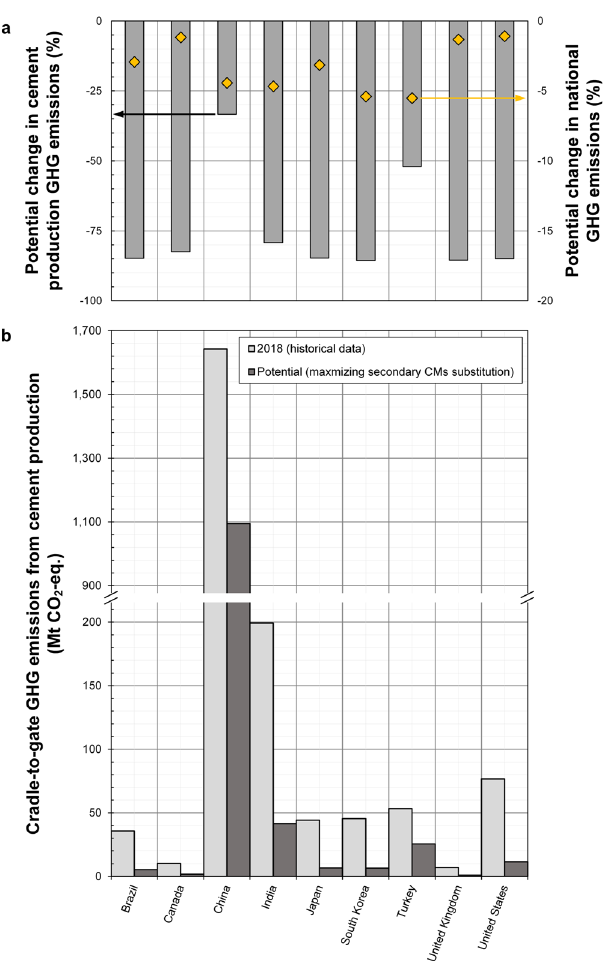
Fig. 5 | Potential reductions in life cycle greenhouse gas (GHG) emissions by increasing clinker and cement substitution using secondary cementitious materials (CMs) in several countries. a Potential percent reduction in GHG emissionsfromcementproduction(viaincreasedutilizationofsecondaryCMs,left side) and percent reduction in country-level total GHG emissions in 2018 when substitutingclinkerwithsecondaryCMs(rightside). b Current(2018)andpotential (via increased utilization of secondary CMs) GHG emissions in Mt CO 2 -eq. for cradle-to-gate cement production. Note the y-axis is cut to show GHG emissions from cement production in China and other countries using the same